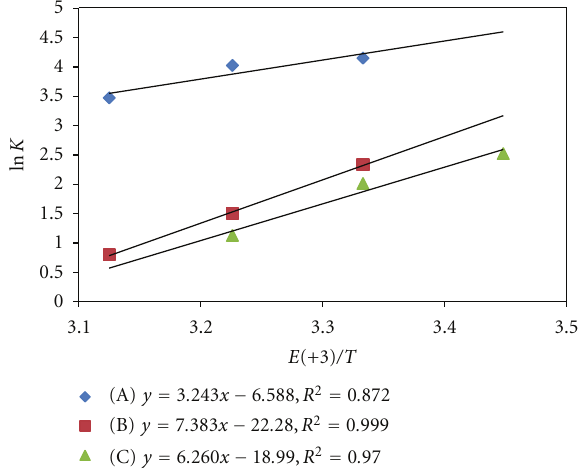
Figure 5: vant Ho ff ’s plot of ln K versus 1 /T for Ru (III) catalyzed reaction. (A) Acetone (B) EMK (C)